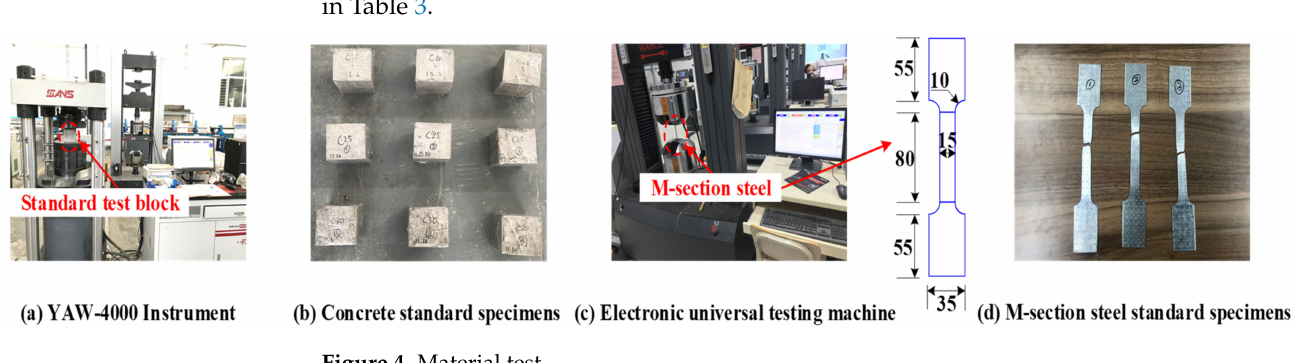
Figure 4. Material test. Table 2. Properties of concrete materials.